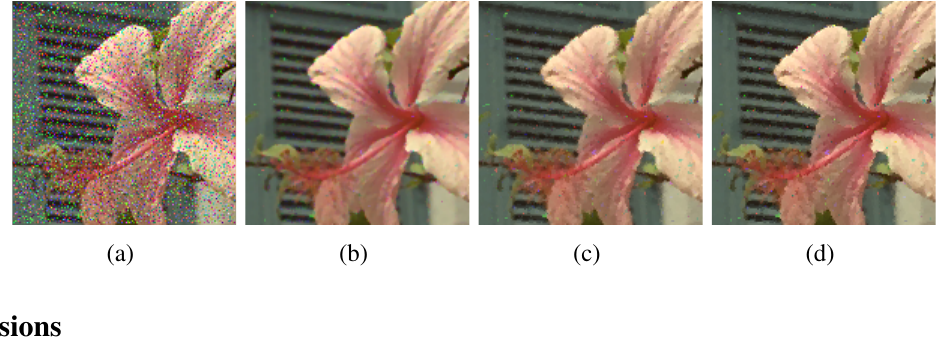
Figure 5. (a) Flower image corrupted with random-value impulse noise with p = 0 : 2 in each colour channel and outputs from: (b) VMMF, (c) VMF and (d) proposed